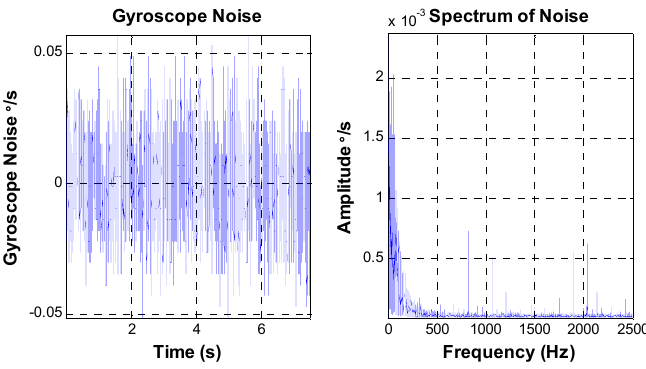
Figure 7. MEMS gyroscope noise characteristics.